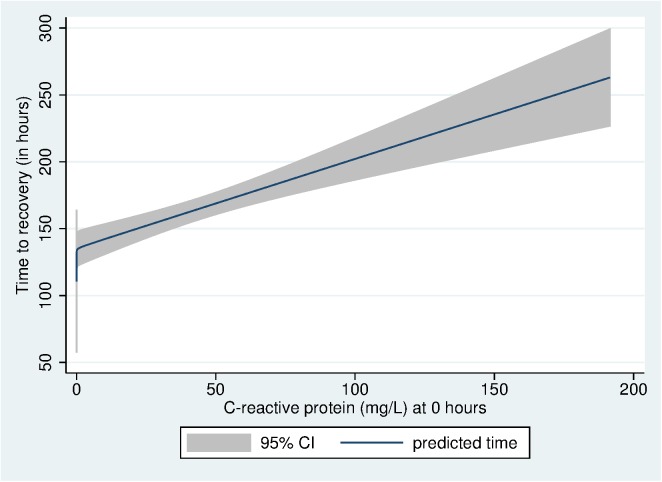
Correlation between baseline CRP level and time to recovery (in hours).Several studies in the past have used cutoffs in the range of CRP concentrations of 40 mg/L to differentiate between bacterial and non-bacterial or viral infections. [11,12]. We therefore also performed an additional analysis where we dichotomized serum CRP concentration with a cut-off of 40 mg/L. In this analysis we found that predictors for time to recovery from PSBI remained the same and infants with CRP ≥ 40 mg/L were found to have on an average 33% longer time to recovery than those with values below that.